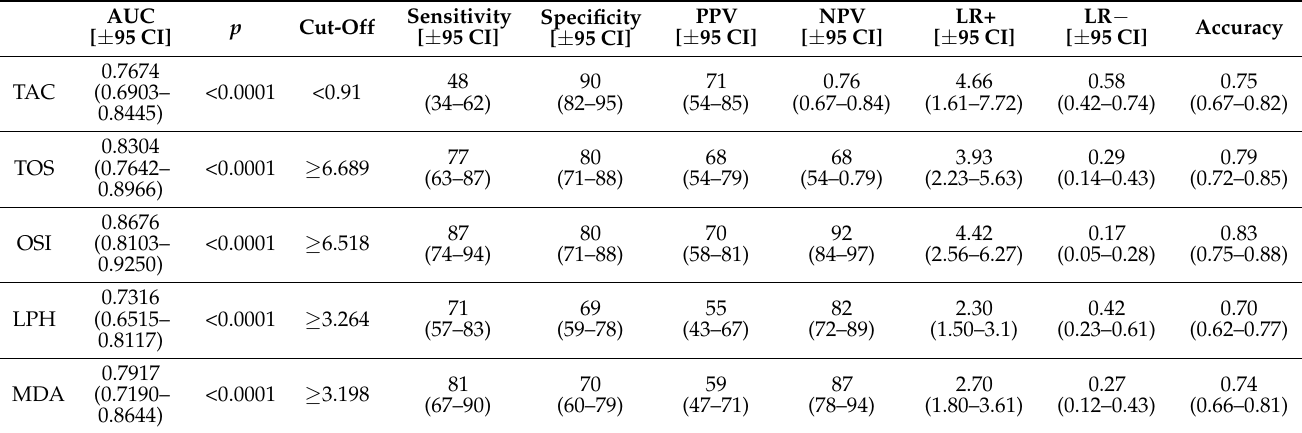
Table 5. A summary of the ROC curve analysis for the analyzed